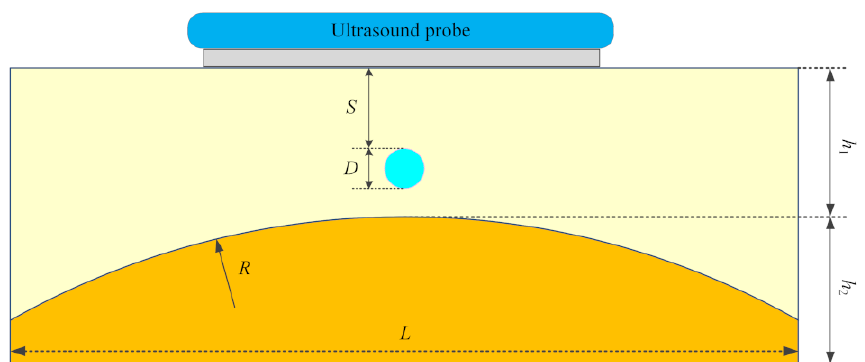
Figure 1. Schematic illustration of a bilayer composite medium with a circular inclusion subjected to ultrasound plane waves.